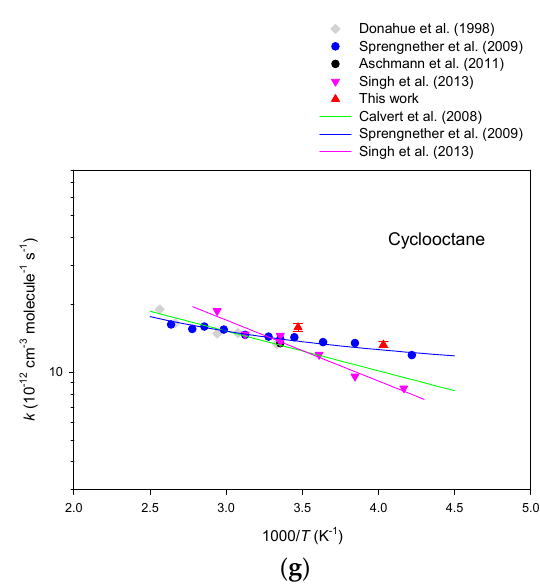
Figure 4. Arrhenius plots of the rate data for the reaction of OH radicals with straight-chain alkanes and cyclooctane in comparison with previous studies [25,39–49].